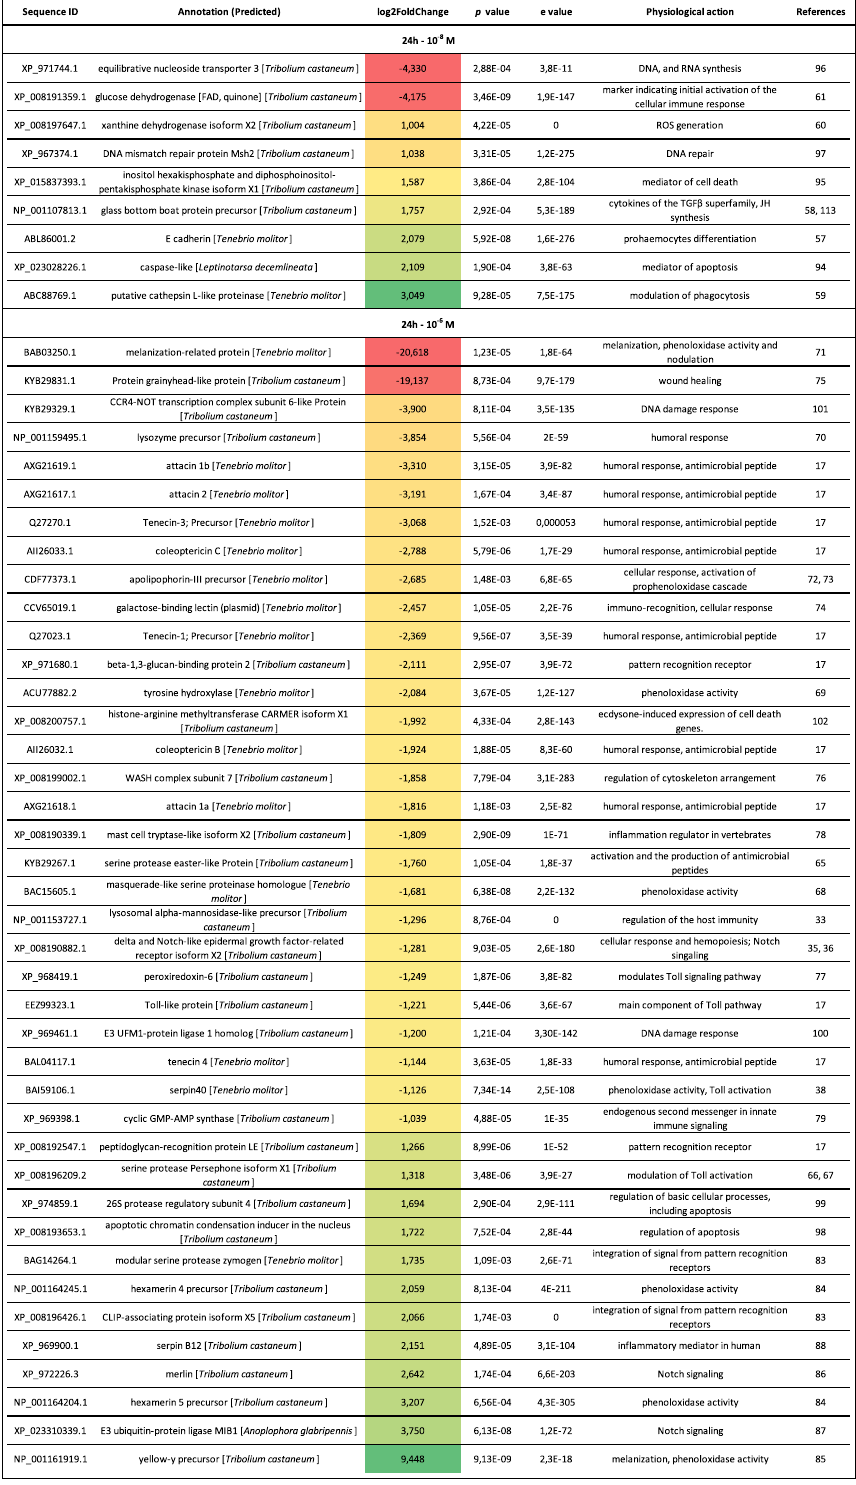
Table 2. Differential expression of selected immune-related transcripts in the fat body and haemocytes of T. molitor 24 h after Tenmo-TRP-7 treatment at concentrations of 10 –8 and 10 –6 M. Gradient from red to green: Fold change values represent the increased (green) or decreased (red) abundance of transcripts (adjusted p value of < 0.05) compared to the control individuals injected with physiological